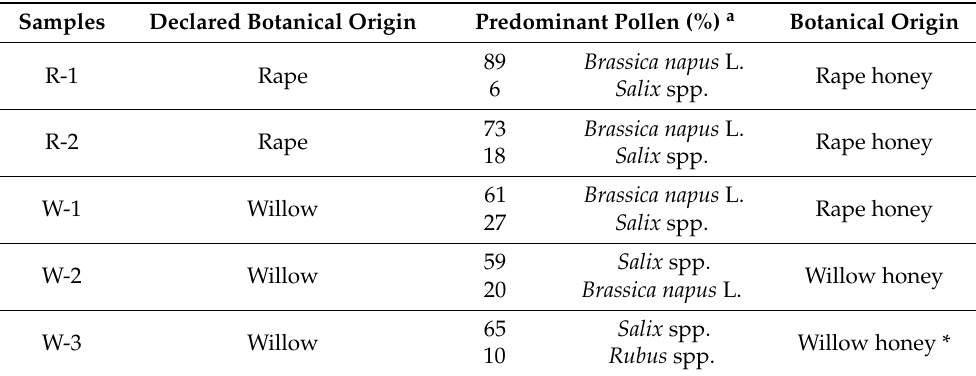
Table 2. Characterisation of the analysed rape and willow